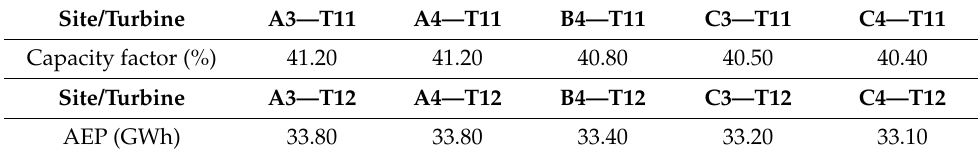
Table 5. Top five capacity factor and AEP corresponding to the shoreline and offshore sites, excluding the points A1, B1, C1, and D1. Results available for the time interval from January 2000 until December 2019.